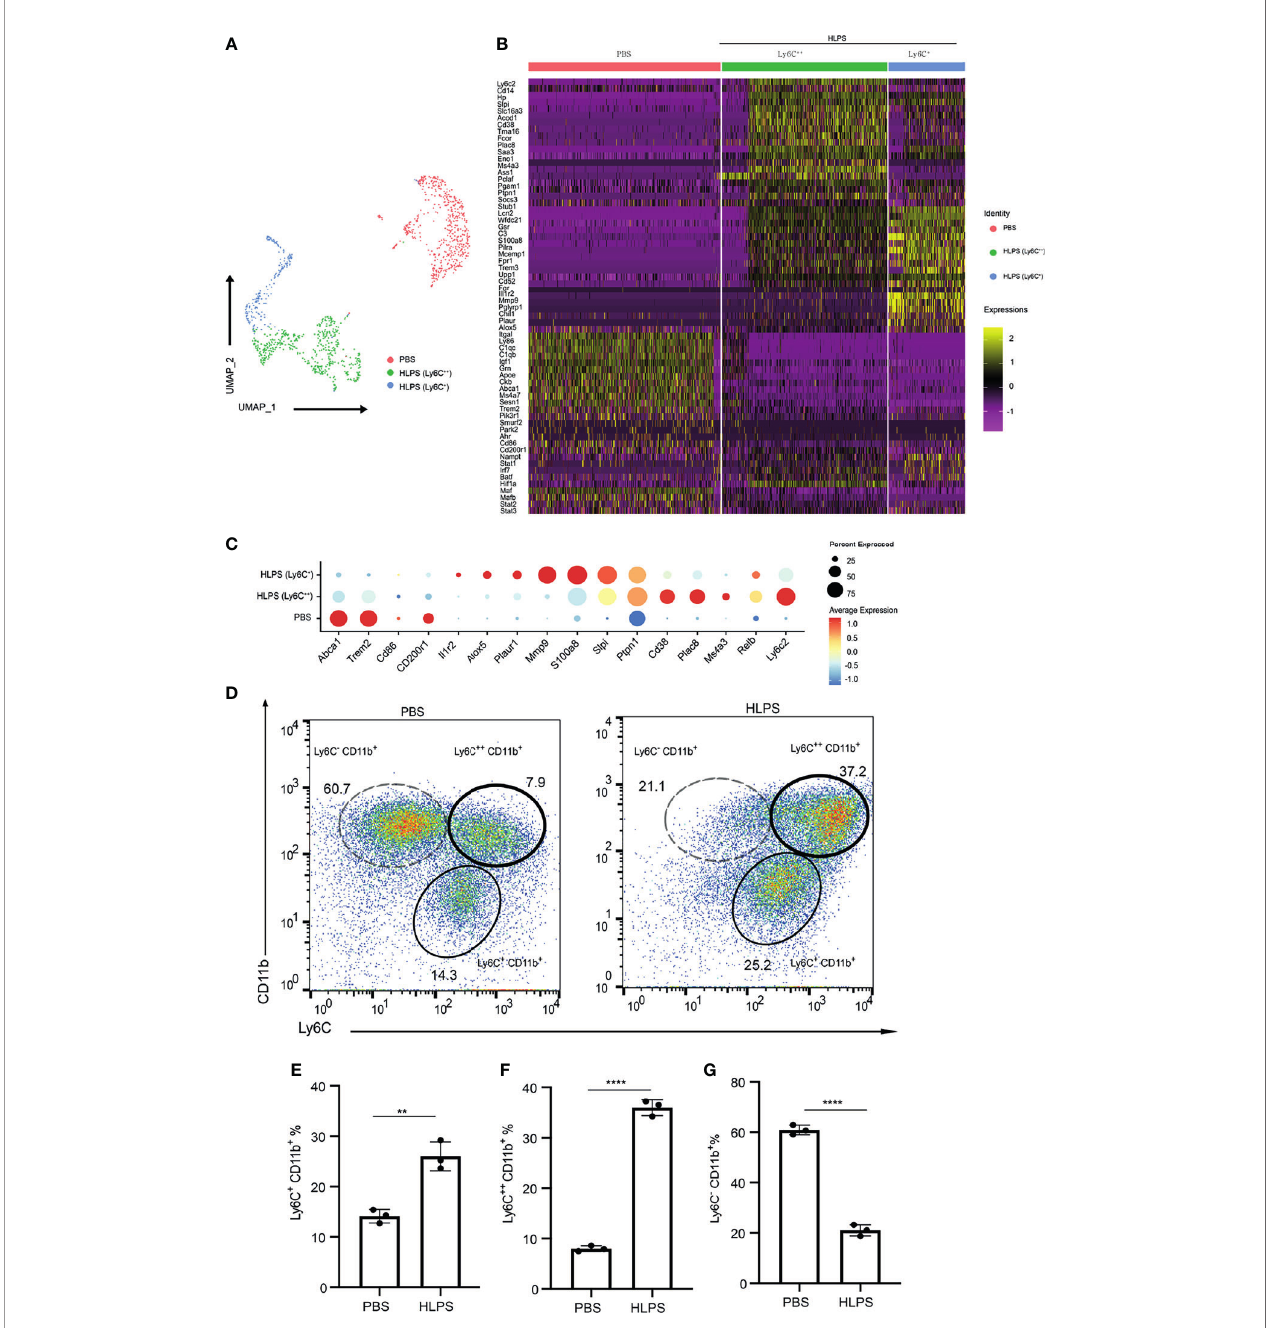
FIGURE 2 | scRNAseq analyses of exhausted monocytes. (A – C) BMDMs were treated with PBS or high dose LPS (100 ng/mL) for 5 days and subjected to scRNA-seq analysis using Chromium Single Cell 3 ’ Reagent Kit V3. PBS control treated (Ly6C - ) cluster and HLPS treated clusters (Ly6C + and Ly6C ++ ) are shown using UMAP plot (A) , Heatmap (B) , and Selected gene dot plot (C) . (D) Ly6C + CD11b + , Ly6C ++ CD11b + and Ly6C - CD11b + populations in the cell cultures challenged with PBS or high dose LPS for 5 days were analyzed with fl ow cytometry. (E – G) The frequencies of indicated populations were quanti fi ed. Around 1000 cells were subjected to scRNA-seq analysis. The fl ow cytometry data are representative of at least three independent experiments, and error bars represent means ± SEM (n=3 for each group). **p < 0.01, ****p < 0.0001, Student ’ s t